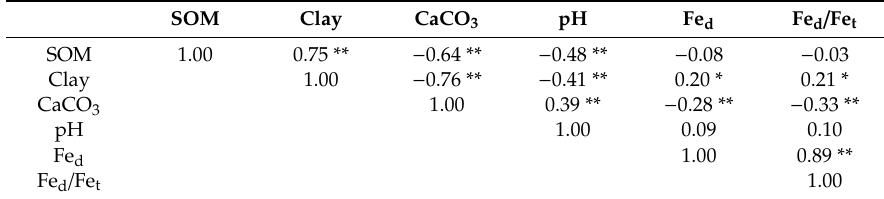
Table 2. Correlation coe ffi cients of six soil